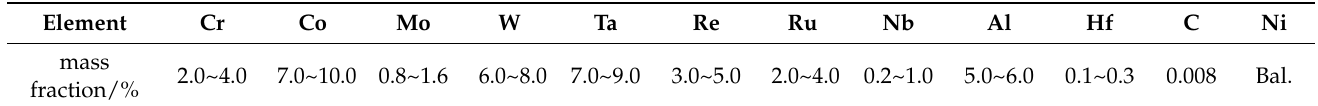
Table 1. Nominal chemical composition of the fourth-generation, nickel-based, single-crystal superal- loy (mass fraction/%)